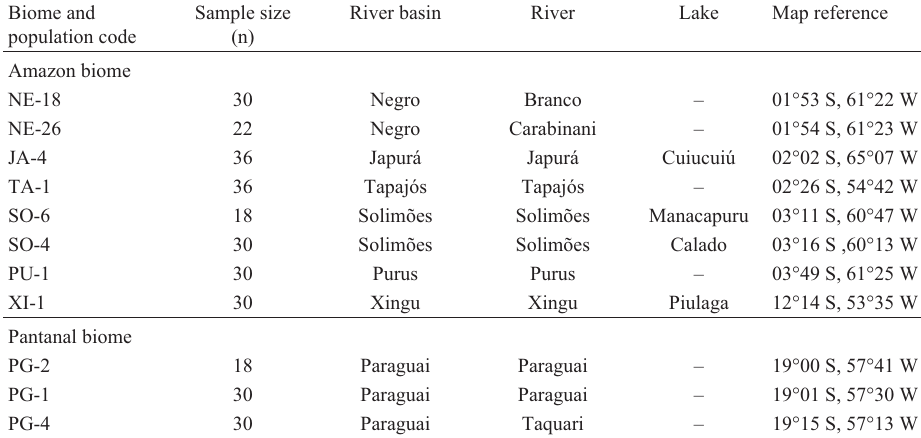
Table1 -Originofthe11Brazilian Oryzaglumaepatula populationsevaluated.Thepopulationsareorderedbylatitude,startingwiththemostequatorial. Except for the XI-1 population, which was collected from a River Amazon tributary in Mato Grosso state, all the Amazon biome populations were collectedfromRiverAmazontributariesinAmazonasandRoraimastates.ThePantanalbiomepopulationswerecollectedinMatoGrossodoSulstate. Biome and population